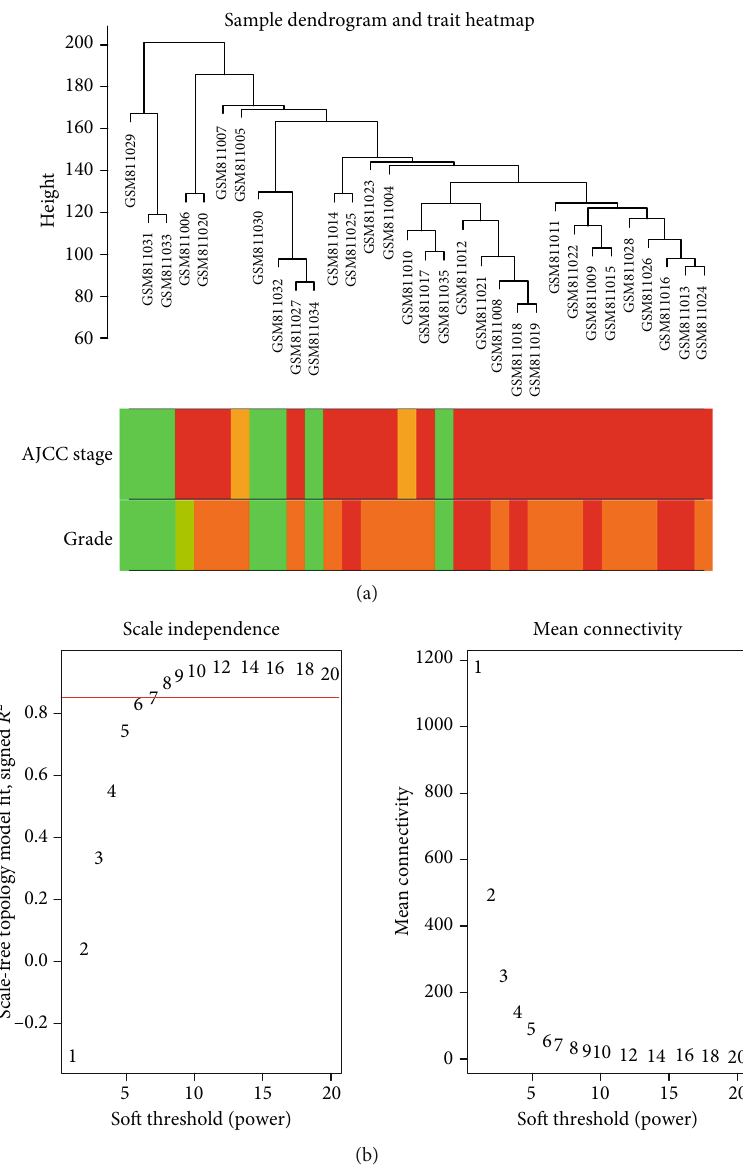
Figure 3: Clustering dendrogram and determination of soft-thresholding power in the WGCNA. (a) Clustering dendrogram of 32 samples. (b) Analysis of the scale-free fi tting indices for various soft-thresholding powers ( β ), and mean connectivity analysis of various soft- thresholding